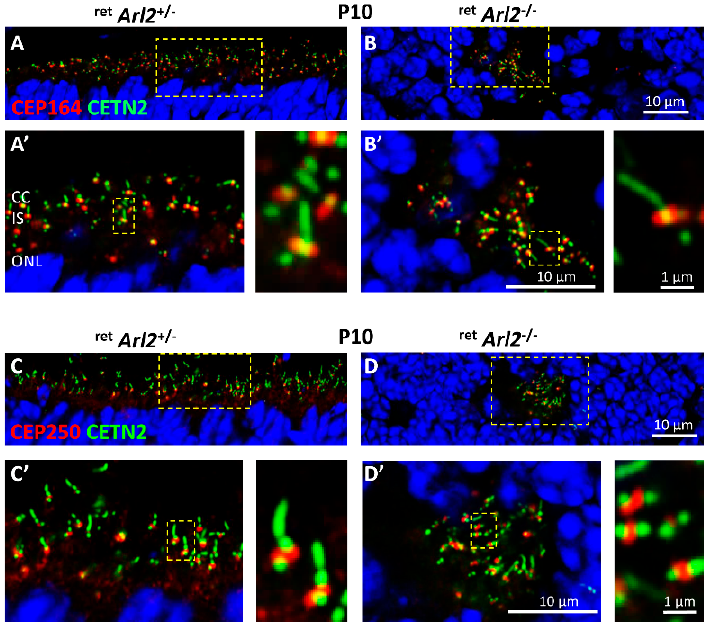
Figure 5. Basal body and CC are mislocalizing into the ONL. ( A – D ) Immunohistochemistry of P10 control ( A , A ′ , C , C ′ ) and ret Arl2 − / − cryosections ( B , B ′ , D , D ′ ) probed with anti-CEP164 antibody ( A – B ′ ), and anti-CEP250 (C-NAP1) ( C – D ′ ). ( A ′ – D ′ ) are enlargements of ( A – D ) as indicted by yellow hatched boxes. To visualize individual rods, enlargements are shown next to ( A ′ – D ′ ). In Arl2 knockout panels, the BB–CC structures are mislocalized into the ONL. CEP164 still enables docking of the basal body and extension of CC, and CEP250 still connects mother and daughter centrioles. Mice were kept on an EGFP-CETN2 transgenic background to mark centrioles and CC. Image was post-processed with Airy Scan of the LSM800 confocal